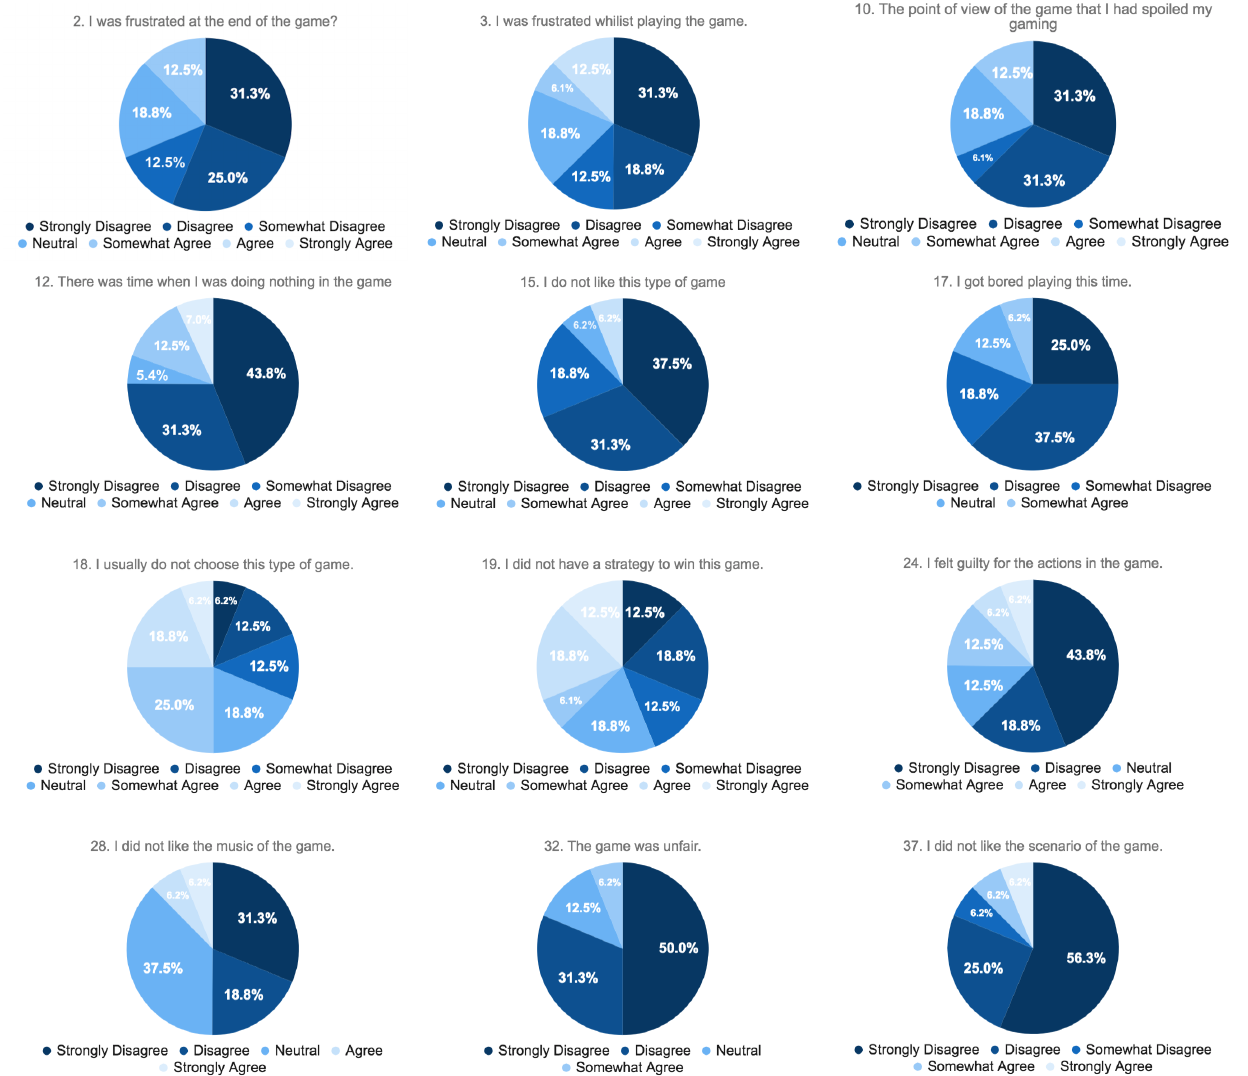
Figure 13. Raw results from the CEGE questionnaire by Calvillo-Gámez et al. (2015), where each question (negatively worded) was answered using a 7-point Likert